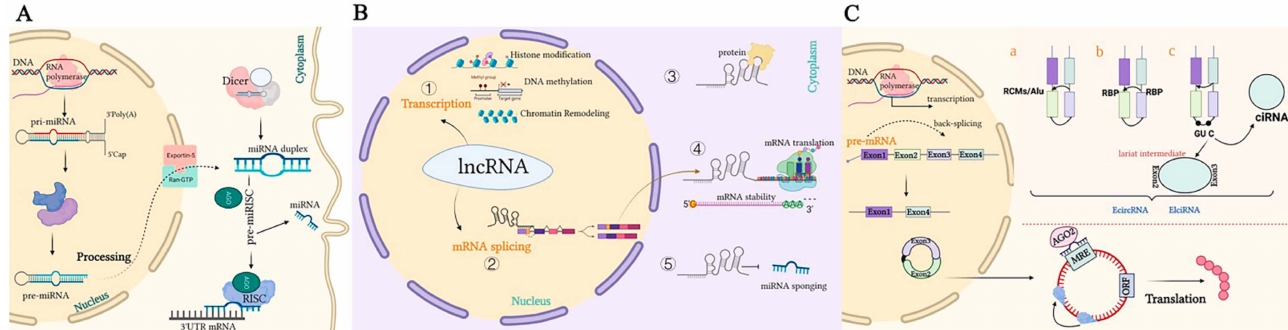
Figure 1. Representation of the biogenesis and mode of action of ncRNAs. ( A ). A pri-miRNA with a double-stranded stem-loop is formed after transcription, which is cleaved by Drosha and DGCR8 with a hairpin-based secondary structure; two nucleotides overhang at its 3 (cid:48) end. Then, pre-miRNAs are exported to the cytoplasm by exportin-5/Ran-GTP. Here, pre-miRNA forms a mature double-stranded miRNA duplex digested by Dicer. The miRISC complex formed by the guide strand miRNA and Ago protein represses target mRNAs by base-pairing at 3 (cid:48) UTR, which prevents translation and selectively silences gene expression. ( B ). Mechanisms underlying long non-coding RNA (lncRNA)-mediated regulation of gene expression. 1 (cid:13) Transcription regulation by lncRNAs. 2 (cid:13) lncRNAs are engaged in the processing and maturation of mRNAs 3 (cid:13) lncRNAs interact with proteins. 4 (cid:13) lncRNAs interact with RNAs. 5 (cid:13) lncRNAs can competitively bind to miRNAs by acting as ceRNAs, thereby blocking the inhibition of the target gene. ( C ). Biogenesis of circRNAs. a. The back-splicing circularization requires the help of complementary sequences (ALU repeats and RCMs). b. RBP-mediated circularization. c. Lariat-driven circularization. circRNA can serve as an miRNA sponge, which inhibits miRNAs in order to regulate the expression of target genes or interact with